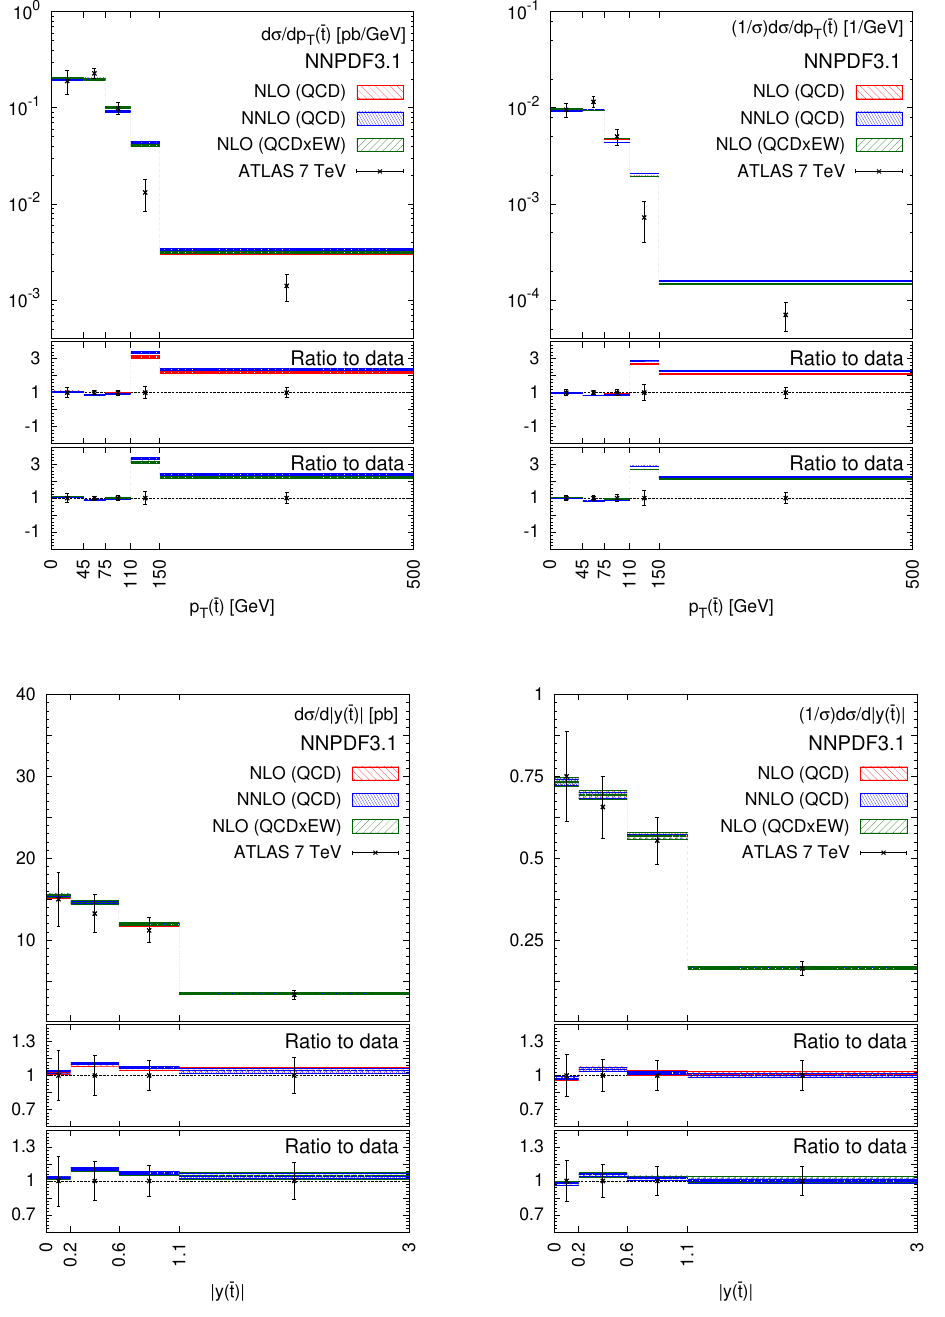
Figure 4 . Same as (cid:12)gure 3, but for top-antiquark production.